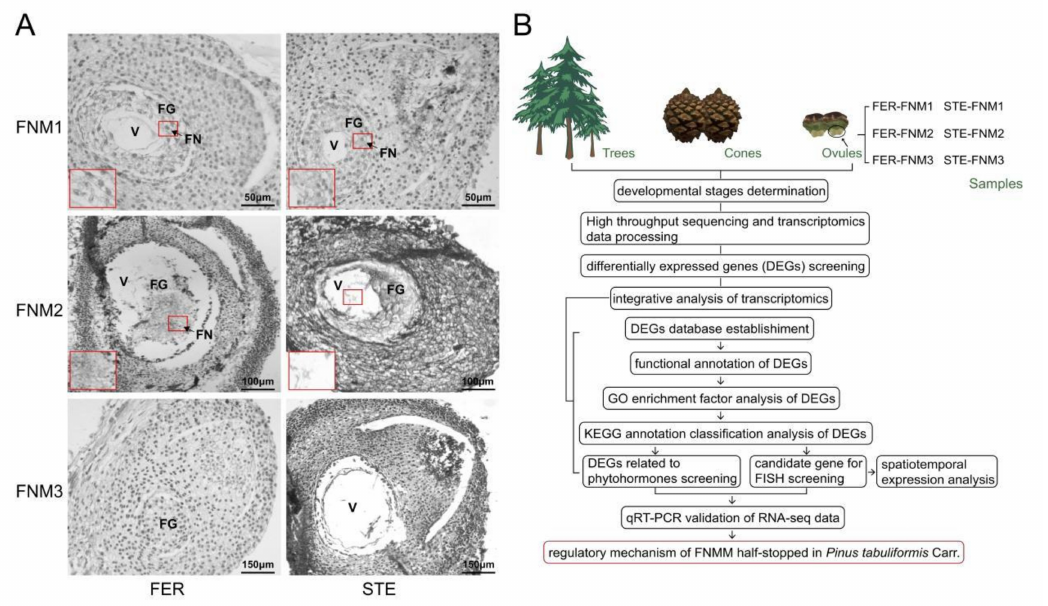
Figure 1. Background description of tissues and workflow. ( A ) Microscopic observations of ovules; FER: female fertile line, STE: female sterile line, FNM: the process of free nuclear mitosis, FG: female gametophyte, FN: free nucleus, V: vacuole. ( B ) Schematic overview of transcriptome data generation and analyses workflow.